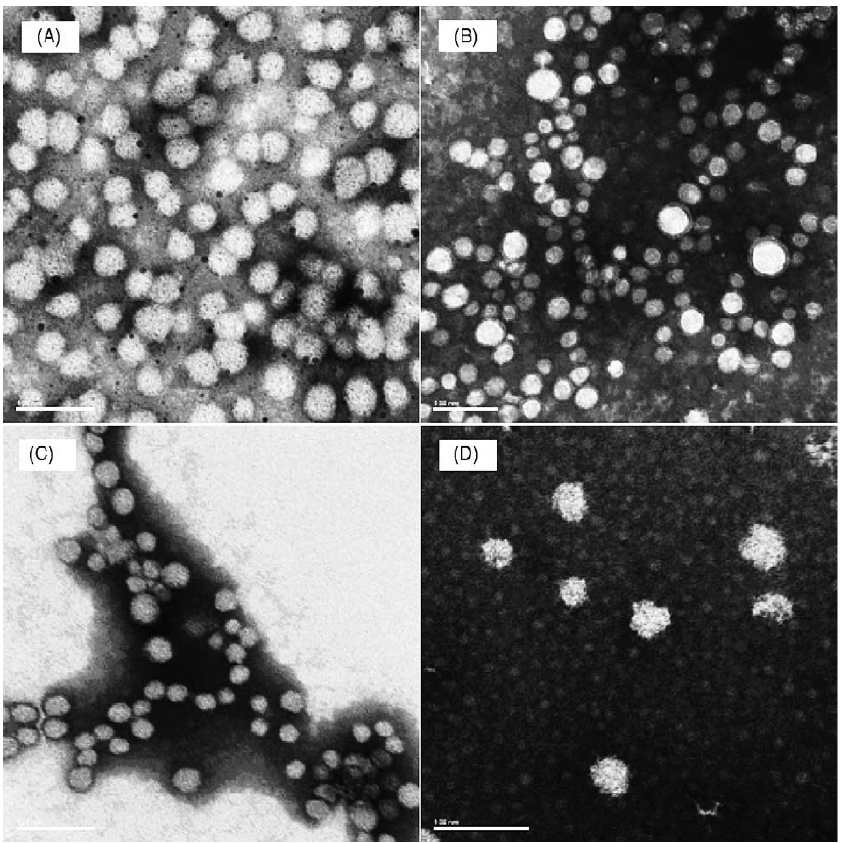
Figure 9. TEM micrographs of CyA-pH sensitive nanoparticles prepared by using (a) poly( N,N -dimethylaminoethyl methacrylate- co -butyl methacrylate- co -methyl meth- acrylate) (Eudragit E100); (b) poly(methacrylic acid-co-ethyl methacrylate) 1:1 (Eudragit L100-55); (c) poly(methacrylic acid- co -methyl methacrylate) 1:1 (Eudragit L100); (d) poly(methacrylic acid- co -methyl methacrylate) 2:1 (Eudragit S100). Reprinted with permission from ref. 226, Copyright © 2009, Elsevier